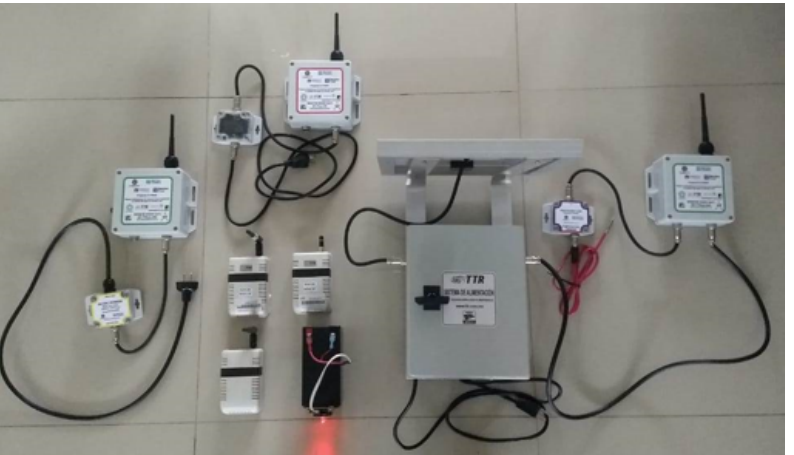
Figure 2. Wireless network with set of radio frequency nodes, coordinator node, and protective plastic coatings. Radio frequency node: country of origin: Mexico; brand: TTR; model: Node RF, µUSB polarization: 5 V Vcc at 100 mA; polarization RJ-11 RS-485 port: 5–12 V Vcc at 100 mA; operating frequency: UHF-2.4 GHz; connection port: RS-485, USB; material: ABS plastic; dimensions: 109.5 × 70 × 38 mm; white color. Radio frequency sensor/router: country of origin: Mexico; brand: TTR; model: Node RF; RS-485 port polarization: 5–12 V Vdc at 100 mA; end devices: 100; nodes in the network: 100; jumping capacity: 15; operating frequency: UHF-2.4 GHz; connection port: RS-485; material: ABS plastic; dimensions: 120 × 120 × 60 mm; white